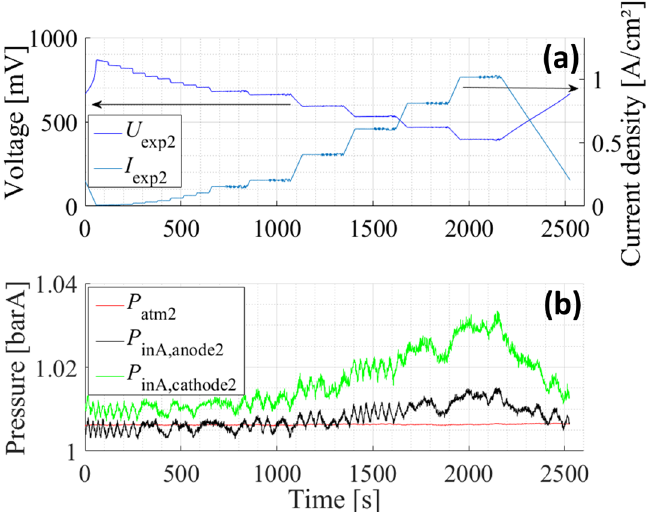
Figure 2. ( a ) Temporal evolution of the voltage ( U exp2 ) and current ( I exp2 ); ( b ) Corresponding H 2 ( P inA,anode2 ) and air ( P inA,cathode2 ) inlet pressures and atmospheric pressure ( P atm2 ). Recorded during a polarization curve of an Advent PBI MEA (45.2 cm²) realized between 0 (open-circuit voltage) and 1 A/cm² at 160 °C, without back-pressure regulation and with stoichiometries of 1.2/2 for H 2 /air.